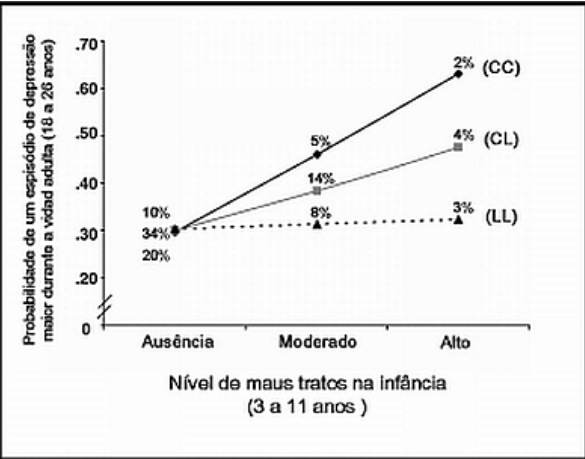
Figura 3 . Análise de regressão para estimar a associação entre os maus tratos durante a infância (entre 3 e 11 anos de idade) e a ocorrência de depressão na fase adulta (entre 18 e 26 anos de idade) de acordo com o tipo de genótipo do transportador da serotonina: CC- duas cópias do alelo de gene curto; LL, duas cópias do alelo de gene longo; CL, uma cópia de cada alelo. Os números distribuídos nas três retas indicam a porcentagem